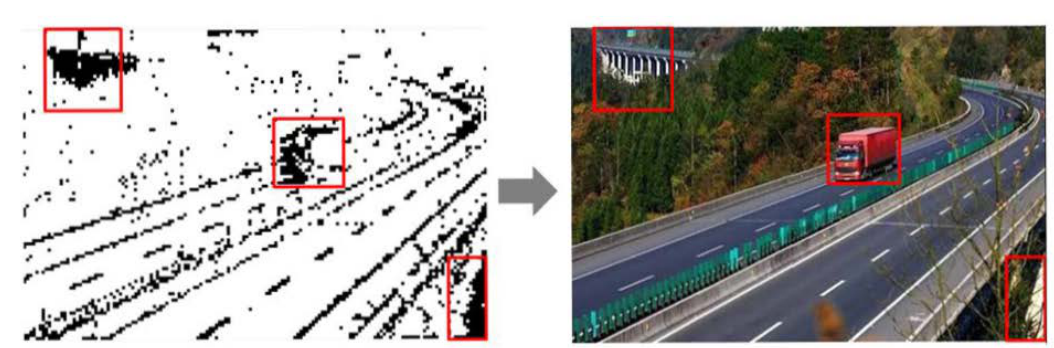
Figure 7. Window-calibration result based on the saliency map.